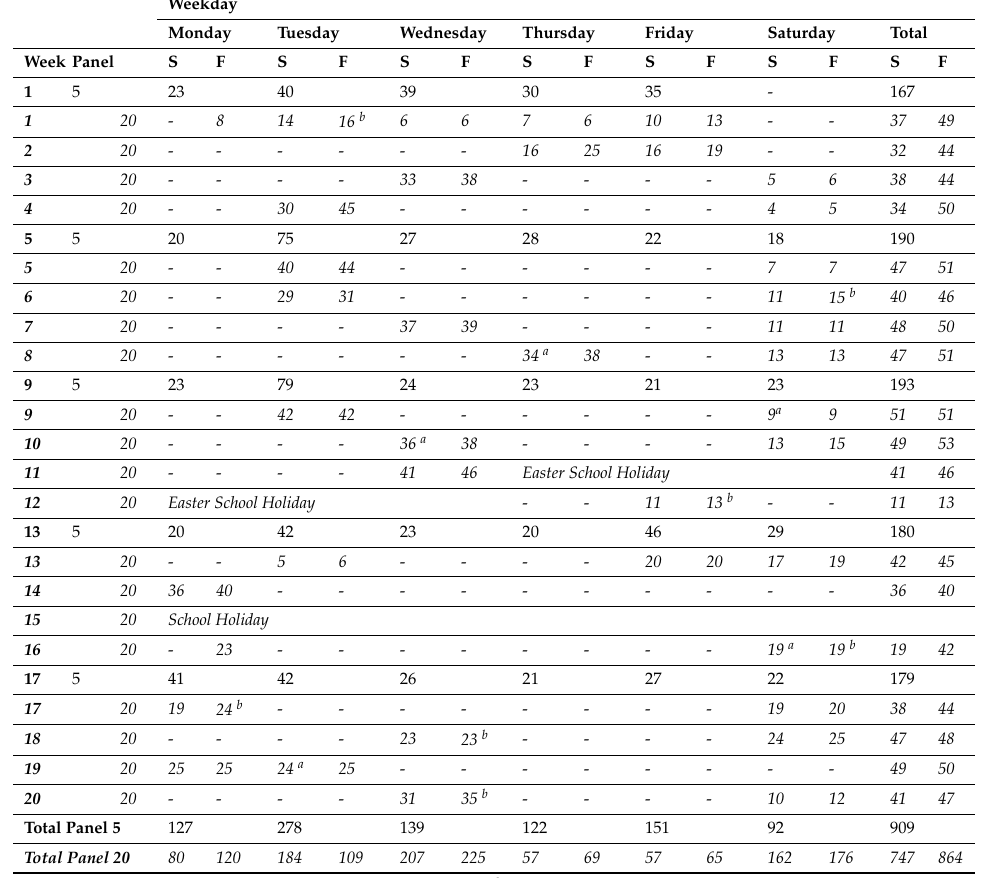
Table 2. Number of spirometric (S) and fractional exhaled nitric oxide (F) measurements by week and day of the week 2 in children enrolled in the Panel 5 and Panel 20 studies in Sarroch (Sardinia), Italy (January–June 2007).